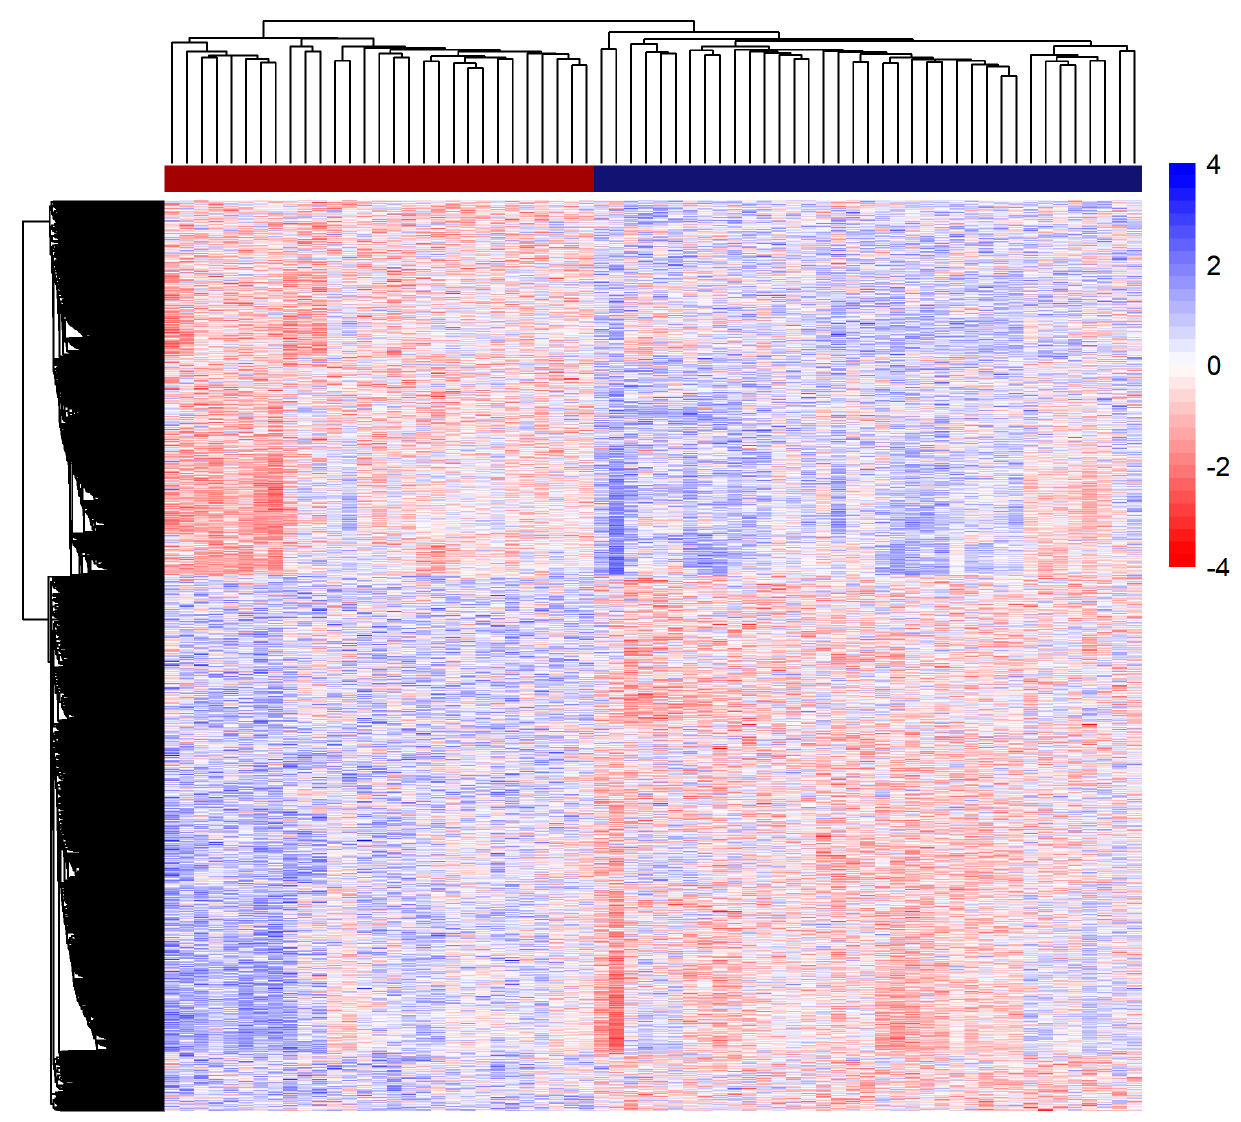
Figure 2. Heatmap of VMR-enriched DMPs. Each line represents the z-score normalized M-value of a CpG site (higher and lower methylation color-coded as blue and red, respectively). Clusters found in methylomics unsupervised analysis (upper bar, Group A in dark red an Group B in dark blue) coincide with above and below average groups of PC1.